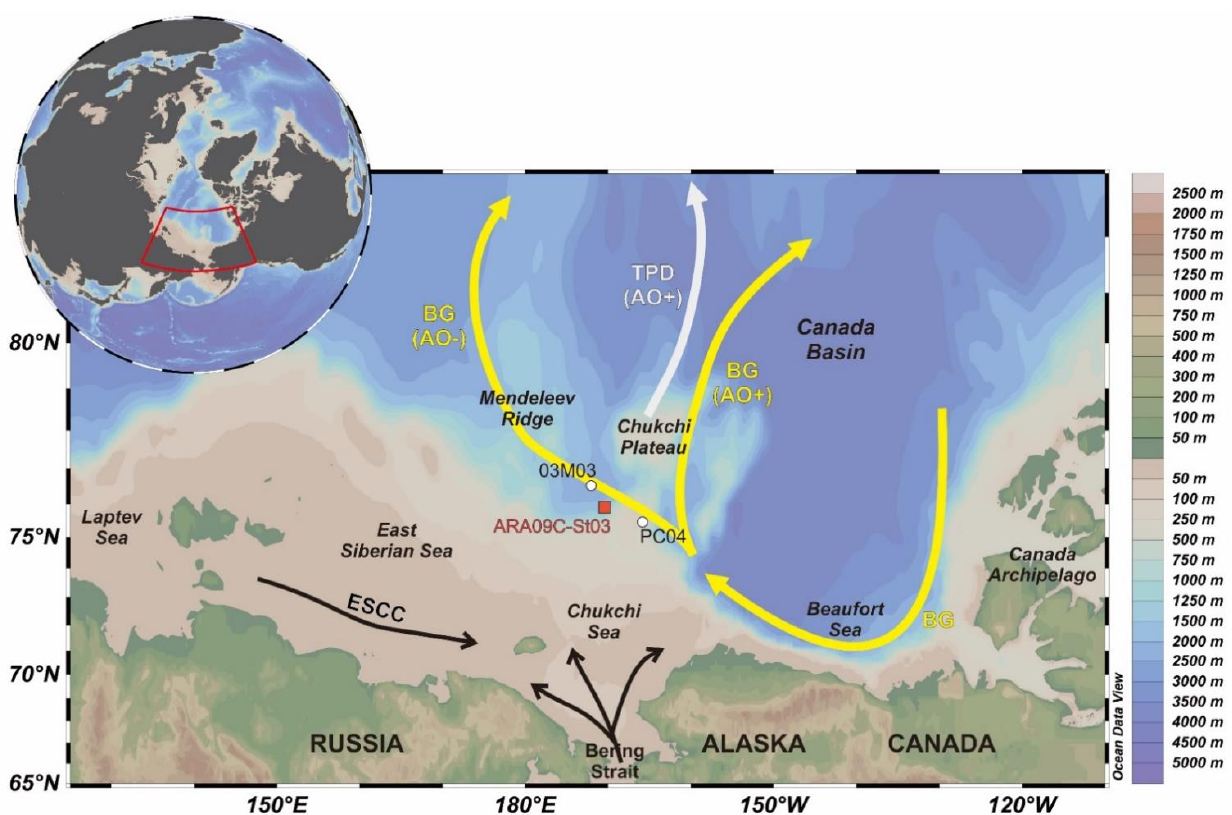
Figure 1. Schematic map showing the location of core ARA09C-St03 in the present study and other sediment records used for comparison in the present study (PC04, [21]; 03M03, [23]) in the western Arctic. The circulation paths (arrow) are modified [14,17]. BG: Beaufort Gyre. ESCC: East Siberian Coastal Current. TPD: Transpolar Drift. AO+ and AO- indicate the paths of currents in the positive and negative phases of the Arctic Oscillation, respectively.